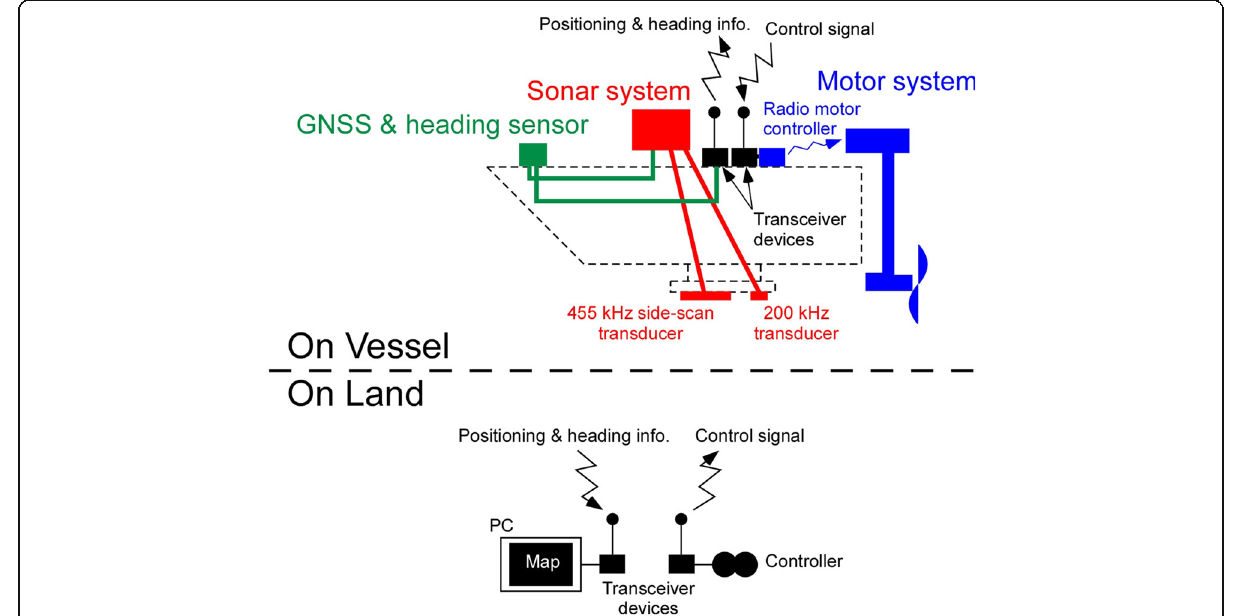
Fig. 2 The concepts behind the remote-controlled watercraft survey system. The watercraft has four systems: motor (blue), sonar (red), GNSS receiver and heading sensor (green), and transceiver (black). The positioning and heading information are transmitted to a PC on land, and the operator can watch the trace and real-time position on a PC display and transmit a signal to a radio controller to operate the